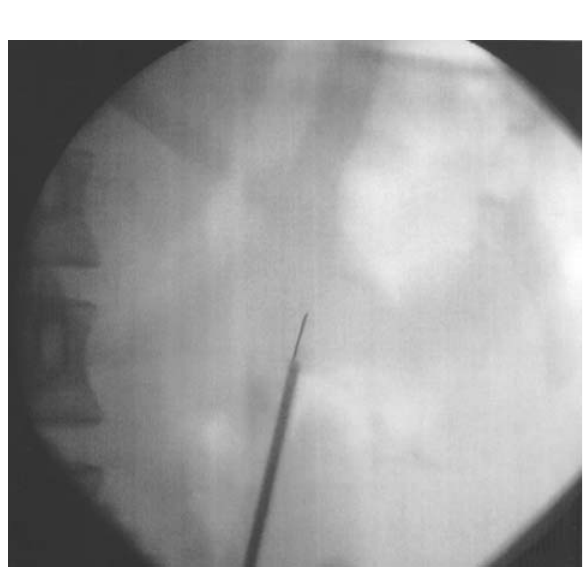
Figure 3 – Transluminal puncture under ultrasound guidance is performed using the stiff end of the guide-wire.